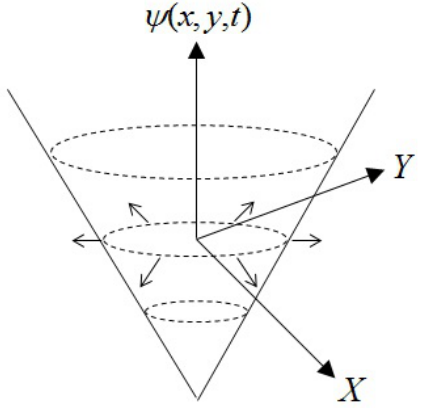
Figure 8. Geometric active contour